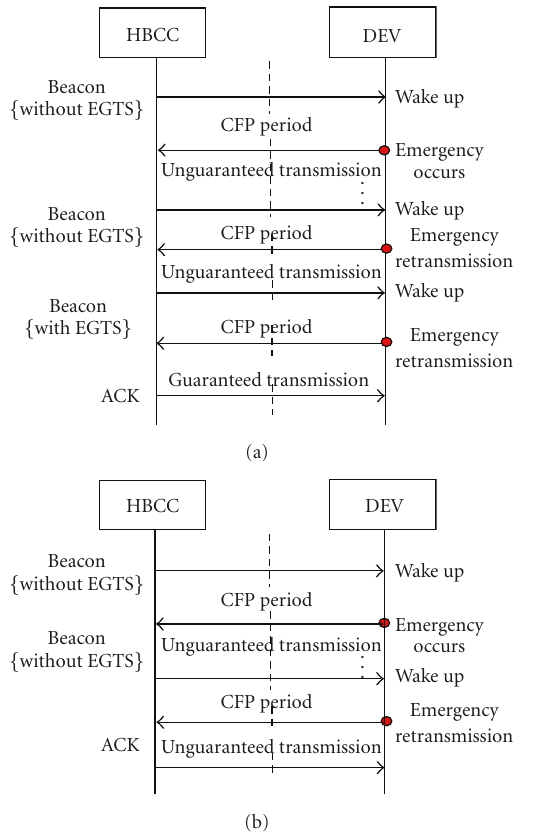
Figure 5: (a) Emergency alarm occurs within superframe interval without EGTS (successful in CAP). (b) Emergency alarm occurs within superframe interval without EGTS (successful in EGTS).